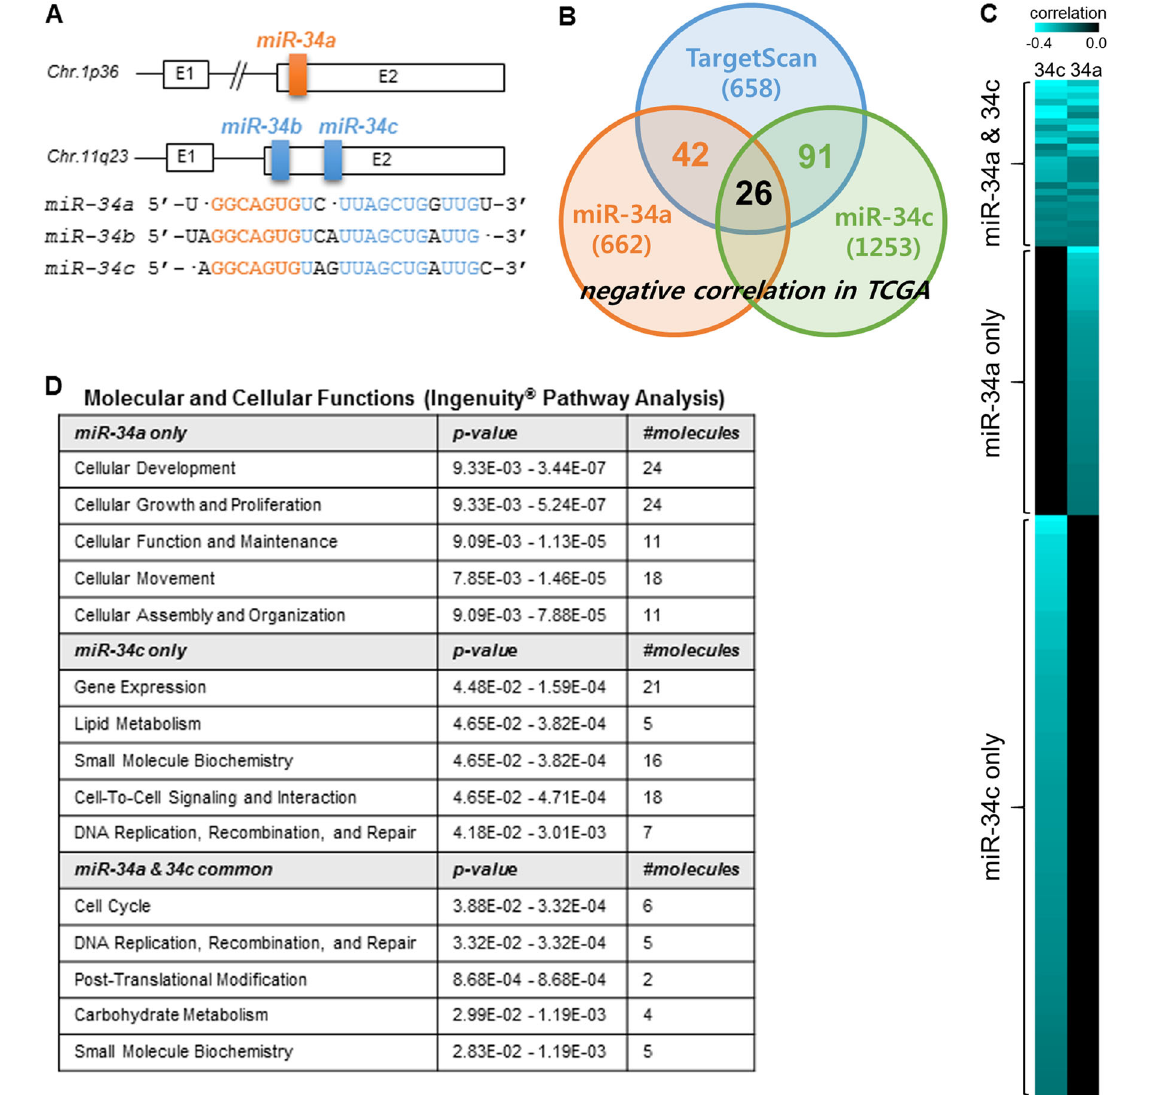
Fig. 1 MiR-34a and miR-34b/c have distinct predicted target genes. a Chromosomal loci of miR-34 family members. Primary miR-34a (pri-miR- 34a; white rectangular boxes) is located on chromosome 1, while pri-miR-34b/c is on chromosome 11. The colored boxes (orange or blue) indicate premature miRNAs. Mature miR-34 sequences are shown in the diagram. Seed sequences are indicated in orange. b Prediction of miR-34 target genes. Target genes of miR-34a and miR-34c were predicted using TargetScan (http://www.targetscan.org). We isolated the negatively correlated genes either with miR-34a or with miR-34c in lung adenocarcinoma data from TCGA (miRGator v3.0, http://mirgator.kobic.re.kr). The combined results are presented in the Venn diagram. c Heatmap of target genes predicted in ( b ). Genes negatively correlated with miR-34a only, with miR-34c only, or with both miR-34a and miR-34c are presented. The blue color intensity is proportional to the correlation coef fi cients. d Ingenuity ® Pathway Analysis (molecular and cellular functions) of the miR-34 target